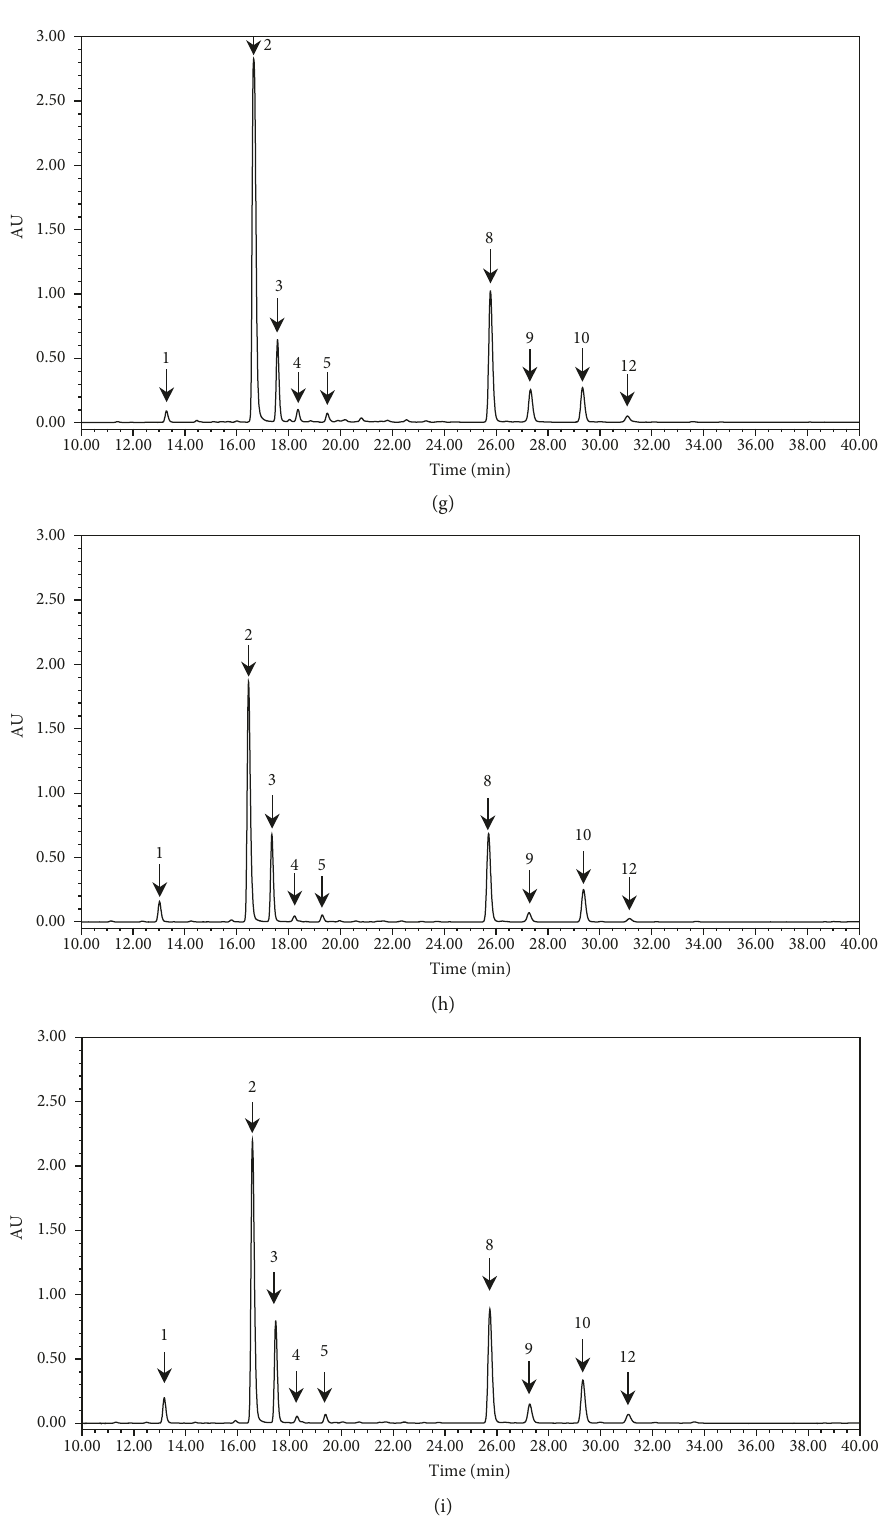
Figure 1: Typical HPLC chromatograms of phenolic compounds of different mulberry leaves: tip of leaves cv. Buriram 60 (a), young leaves cv. Buriram 60 (b), old leaves cv. Buriram 60 (c), tip of leaves cv. Sakonnakhon (d), young leaves cv. Sakonnakhon (e), old leaves cv. Sakonnakhon (f), tip of leaves cv. Khunphai (g), young leaves cv. Khunphai (h), and old leaves cv. Khunphai (i), detected at 350nm and zoom-in spectrum range of 10–40min. The peak numbers are corresponding to UV spectrum and MS data in Table